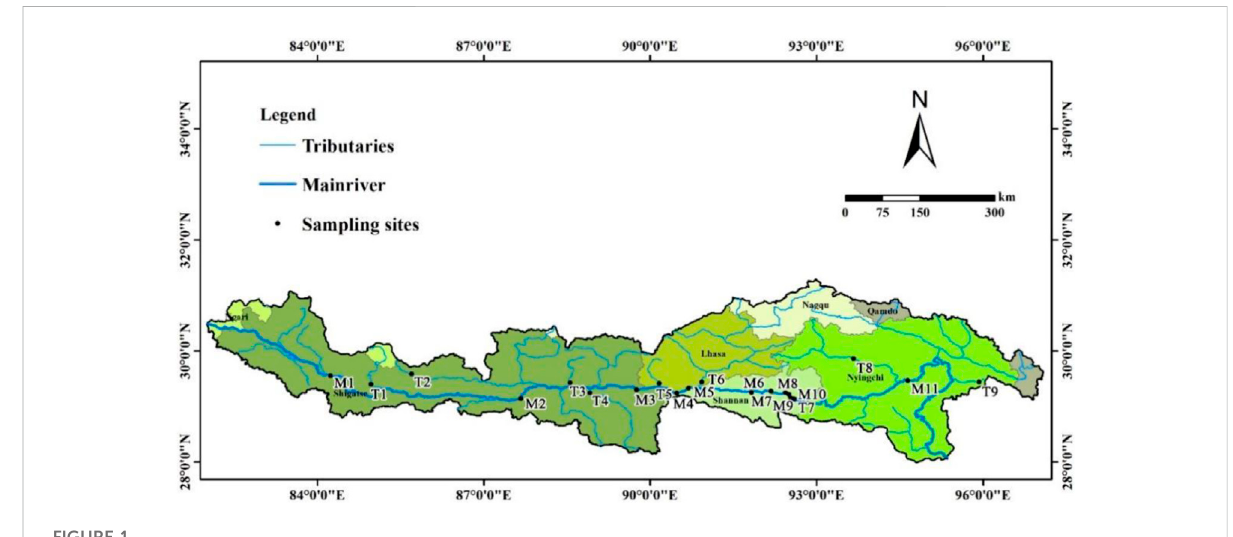
FIGURE 1 Locations of the sampling sites in the Yarlung Tsangpo River on the Tibetan